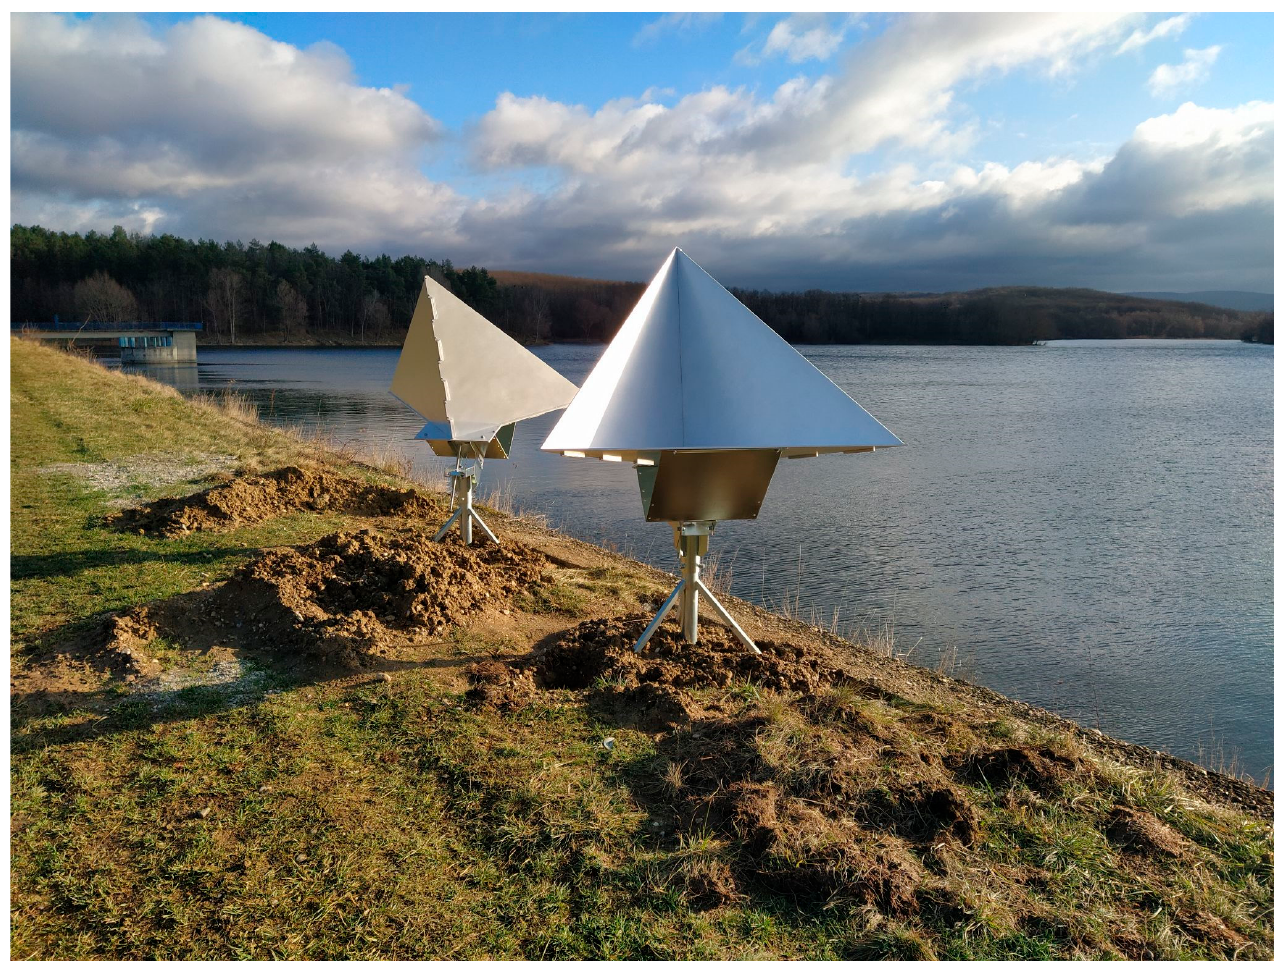
Figure 6. CR pair facing both ascending and descending S1 orbits on a reservoir dam (the overflow drain is in the upper left corner of the picture). Check Figure 7 for localisation.